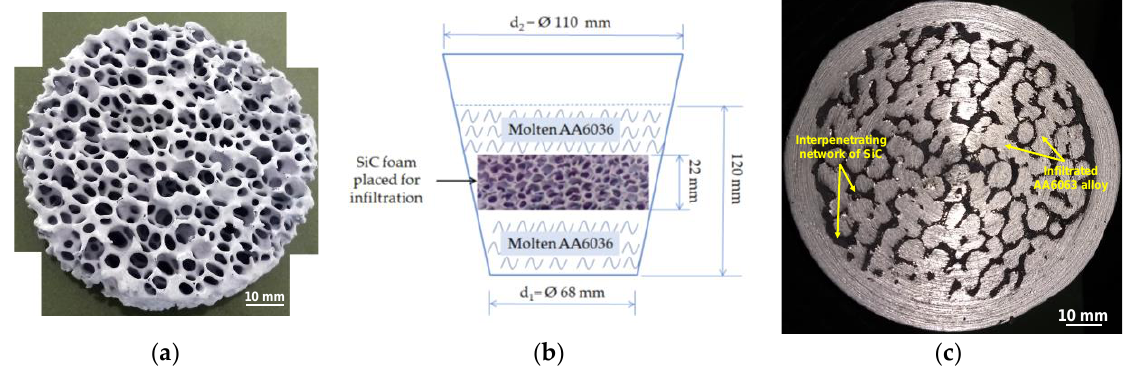
Figure 1. ( a ) SiC Foam of pore size 10 ppi; ( b ) the schematic of infiltration inside a clay graphite crucible; ( c ) the manufactured C4 composite showing the interpenetrating SiC and Al phases.